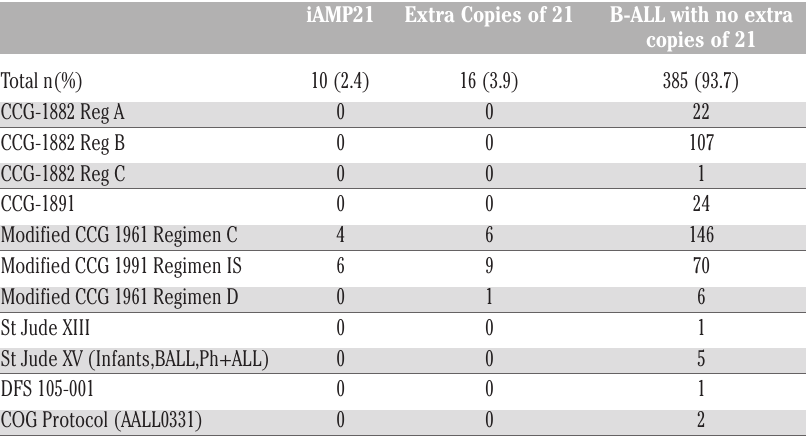
Table 2. Treatment protocols given to